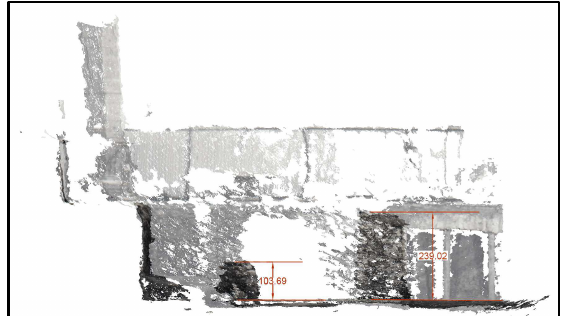
Figure 13 . Height measurements of foundation pilasters in the SfM point